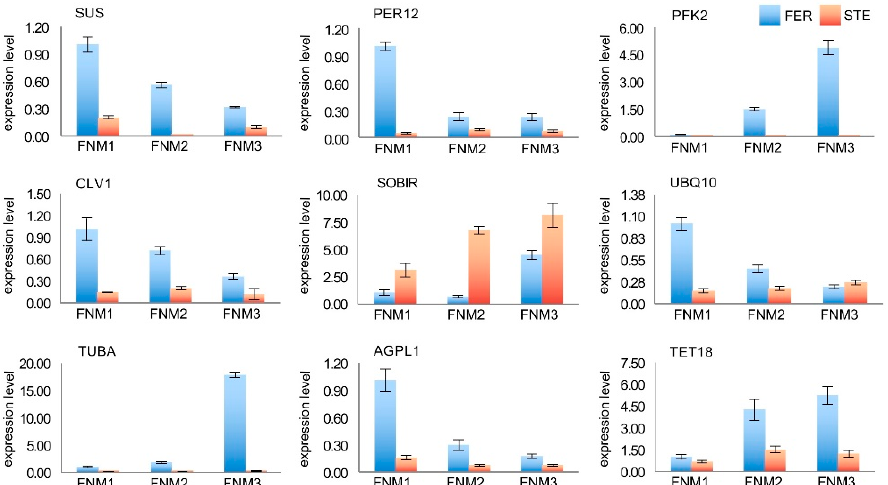
Figure 8. Candidate DEGs’ expression levels, as revealed by qRT-PCR. Sucrose synthase (SUS); peroxidase 12 (PER12); ATP-dependent 6-phosphofructokinase 2 (PFK2); clavata 1-like protein (CLV1); leucine-rich repeat receptor-like serine/threonine/tyrosine-protein kinase SOBIR1 (SOBIR1); polyubiquitin-like 10 (UBQ10); tubulin alpha chain (TUBA); ADP-glucose pyrophosphorylase large subunit 1 (AGPL1); tetraspanin-18 (TET18).